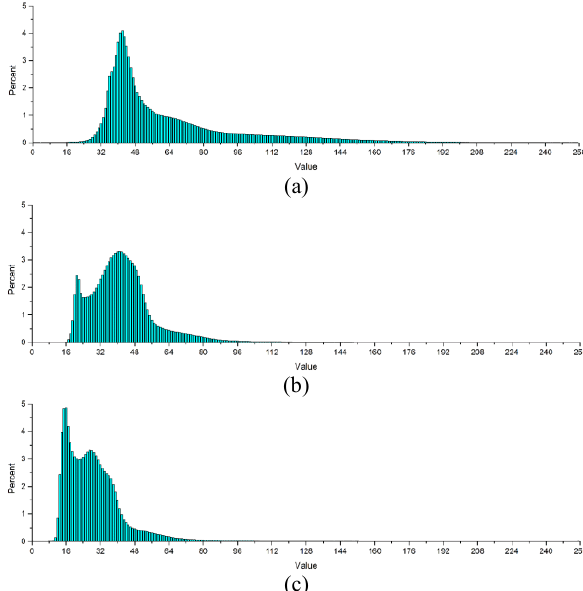
Figure 3. Probability histograms for the multispectral image and the panchromatic stereo pair. (a) Lightness probability histogram for the multispectral image. (b) Gray probability